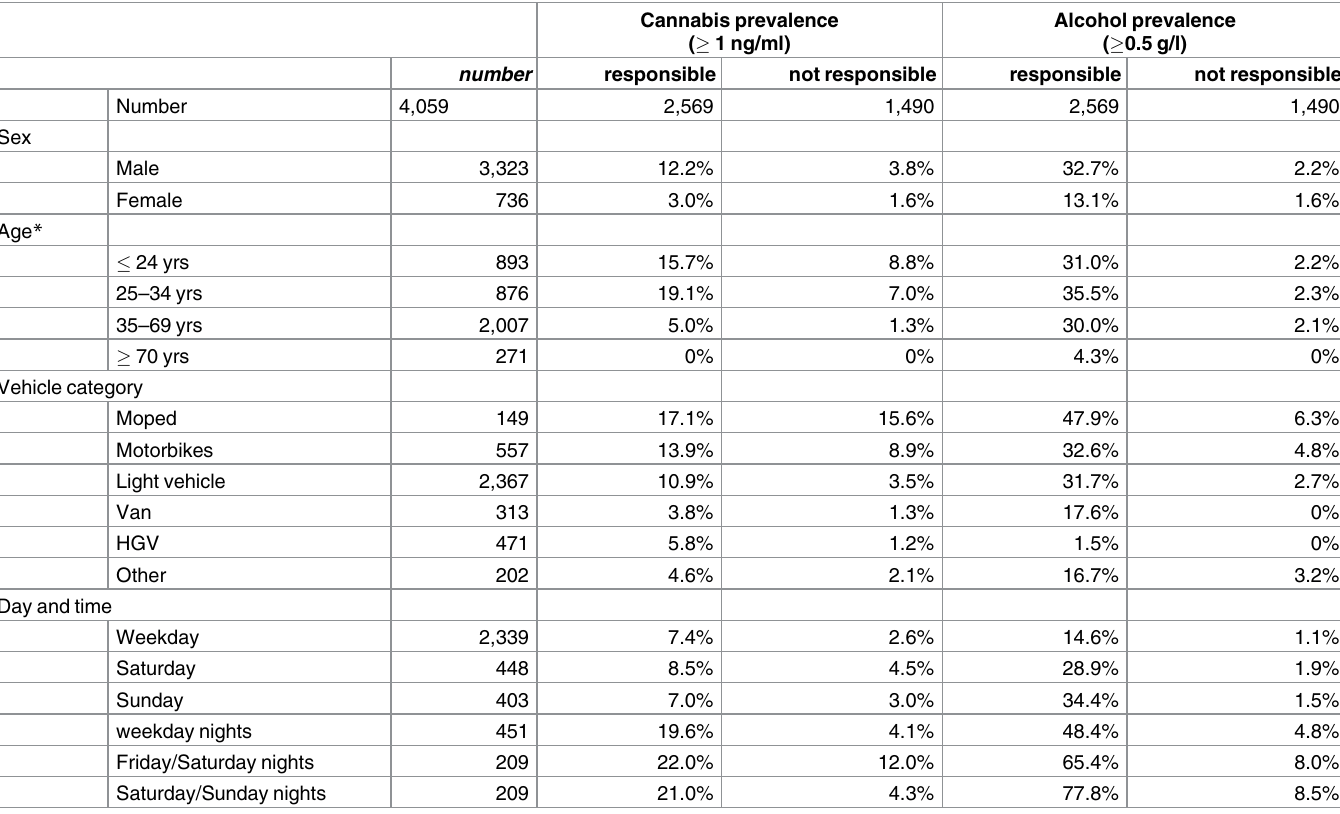
Table 3. Prevalence of cannabis and alcohol among cases(responsible) and controls (not responsible) according to co-factor modalities (data source Voiesur 2011, fatal